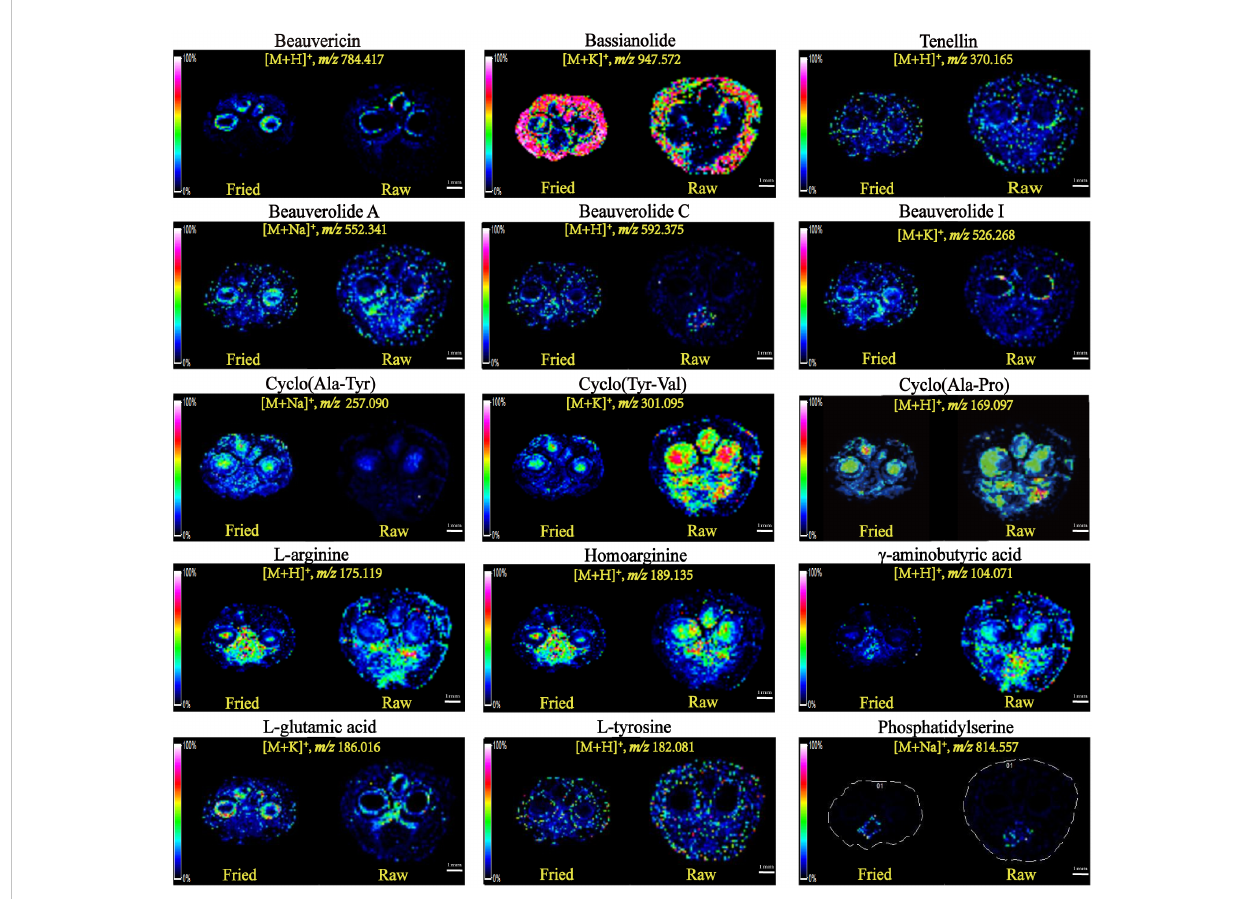
FIGURE 5 Mass spectrometry images of the ions of representative protein-related metabolites in the tissue sections of raw and fried Bombyx